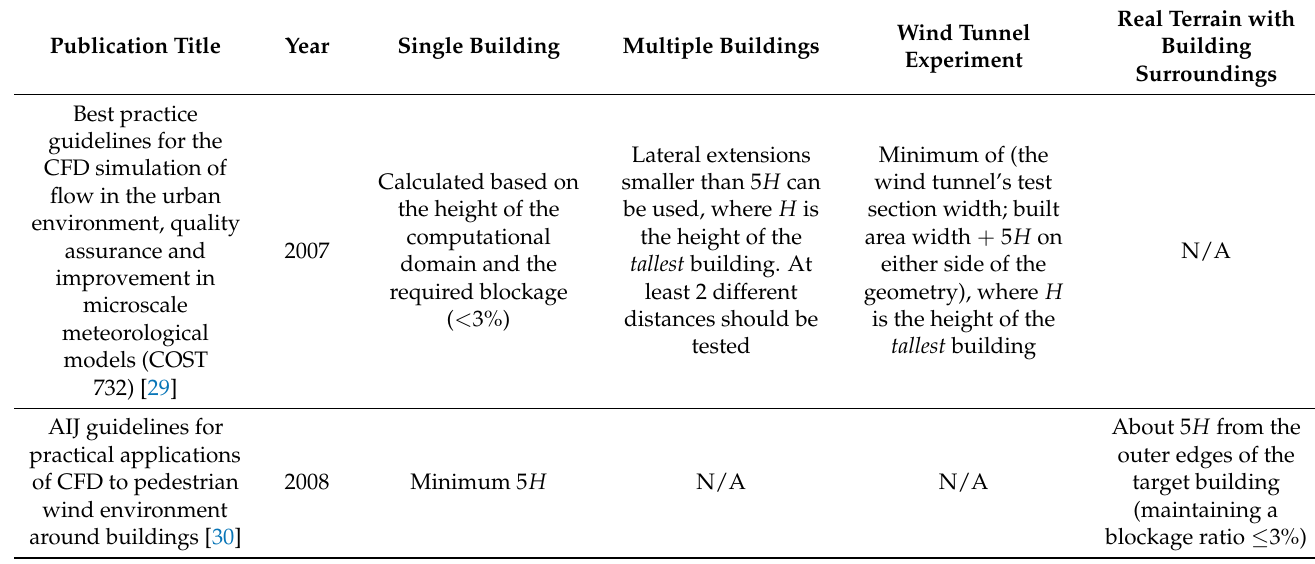
Table 5. Best practice guidelines on domain